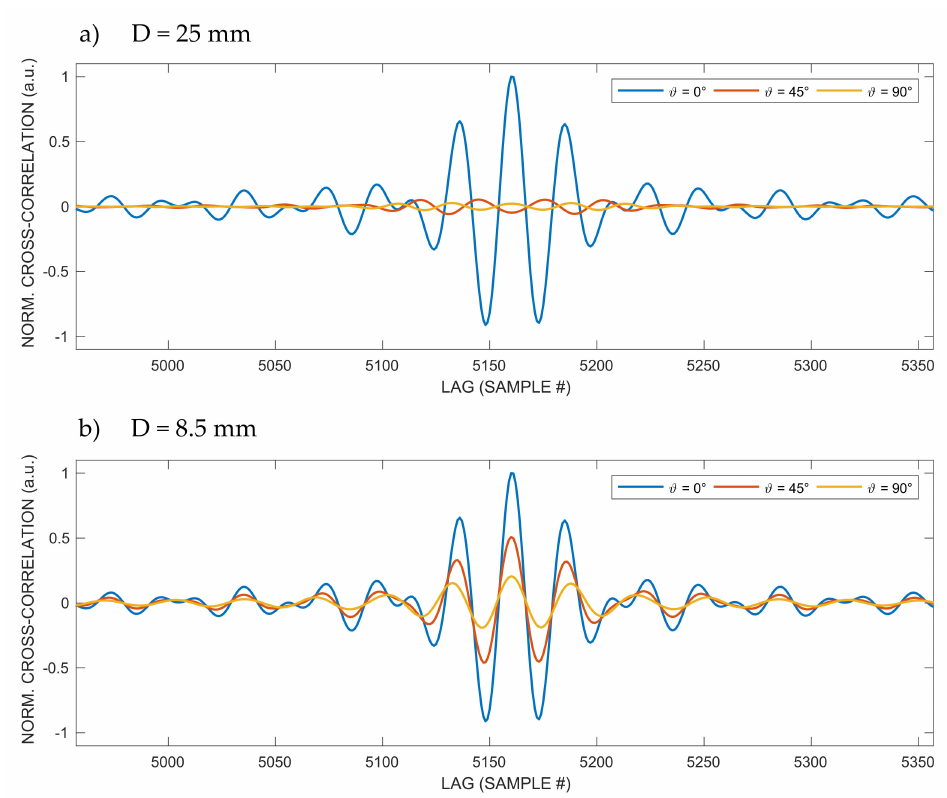
Figure 5. Cross-correlations along a semicircular path at distance R = 1 m from the emitting transducer for two di ff erent transducer apertures: ( a ) D = 25 mm and ( b ) D = 8.5 mm. For D = 25 mm, it is possible to see that the single unique peak of the cross-correlation for ϑ = 0 ◦ is no longer present at the 45 ◦ and 90 ◦ angles, while, for D = 8.5 mm, it is possible to appreciate the single correlation peak at all angles. The cross-correlation values are normalized to their maximum value for each aperture: for D = 8.5 mm, the amplitude relative reduction with respect to the increasing angle is much lower than for D = 25 mm, due to the much wider emission of the smaller